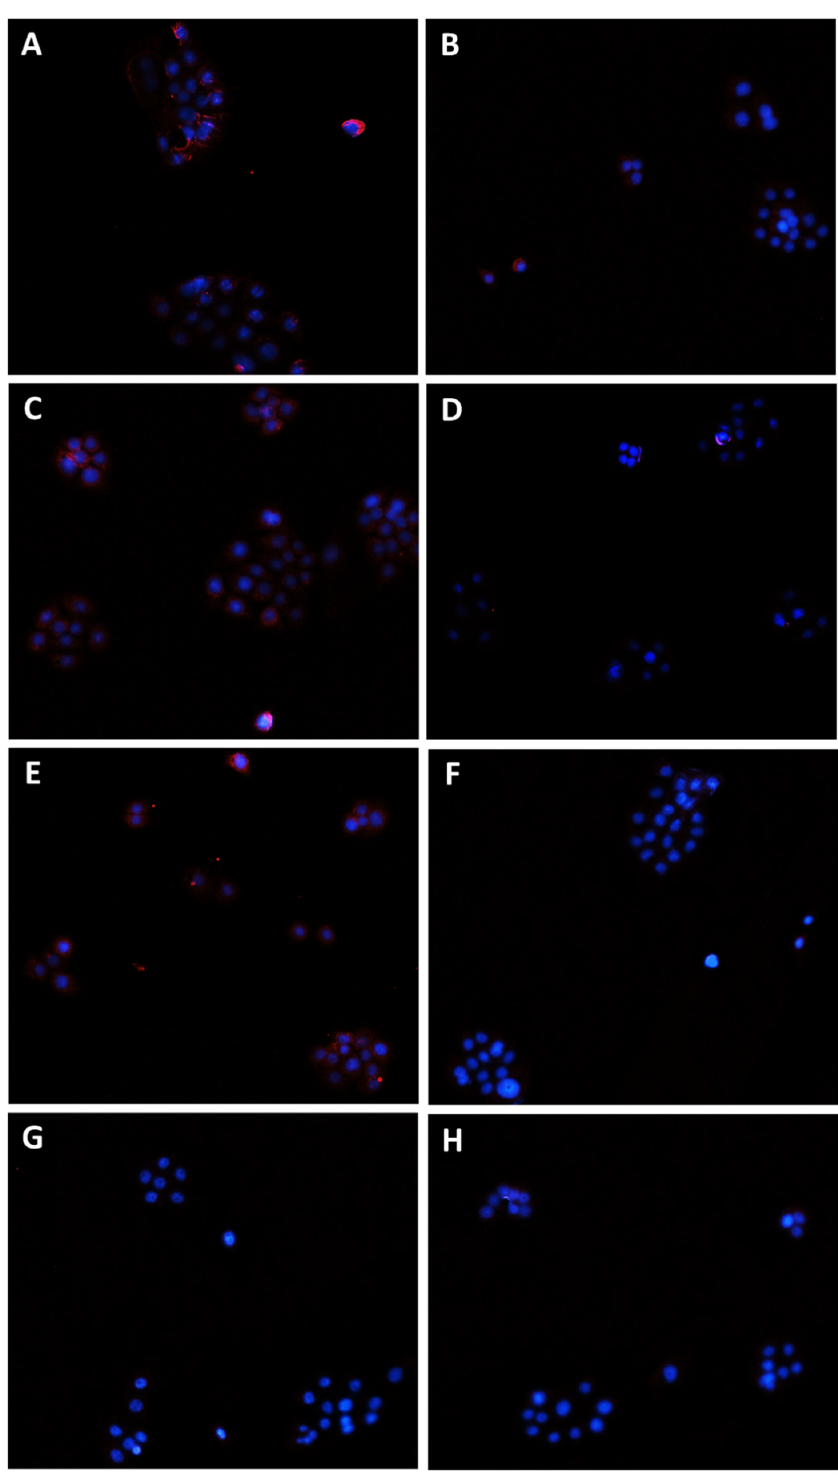
Figure 11. Modulation of MRP2 transporter expression in Bx-PC3 cells detected after 4 h exposure and 72 h recovery time. Representative images obtained at immunofluorescence analysis. Original magnification: 10×. ( A ) Control; ( B ) sorafenib 10 µg/mL; ( C ) MK571 1 µg/mL; ( D ) MK571 1 µg/mL + sorafenib 10 µg/mL; ( E ) β -caryophyllene 10 µg/mL; ( F ) β -caryophyllene 10 µg/mL + sorafenib 10 µg/mL; ( G ) β -caryophyllene oxide 10 µg/mL; ( H ) β -caryophyllene oxide 10 µg/mL + sorafenib 10 µg/mL.